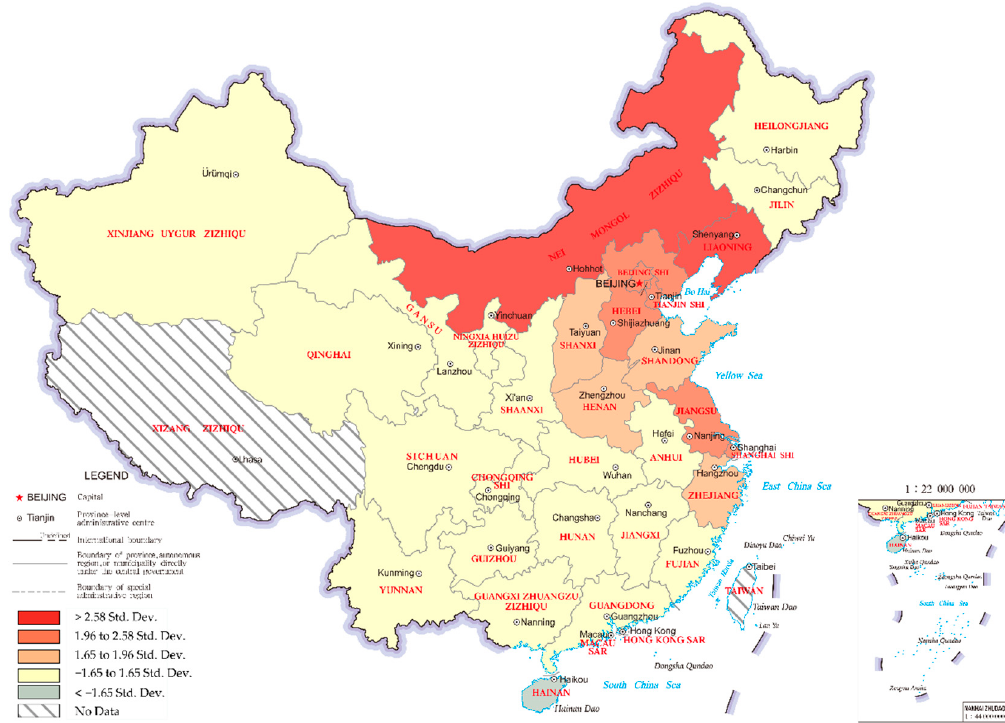
Figure 5. Hotspots of CO 2 emissions in China from 2006 to 2019.